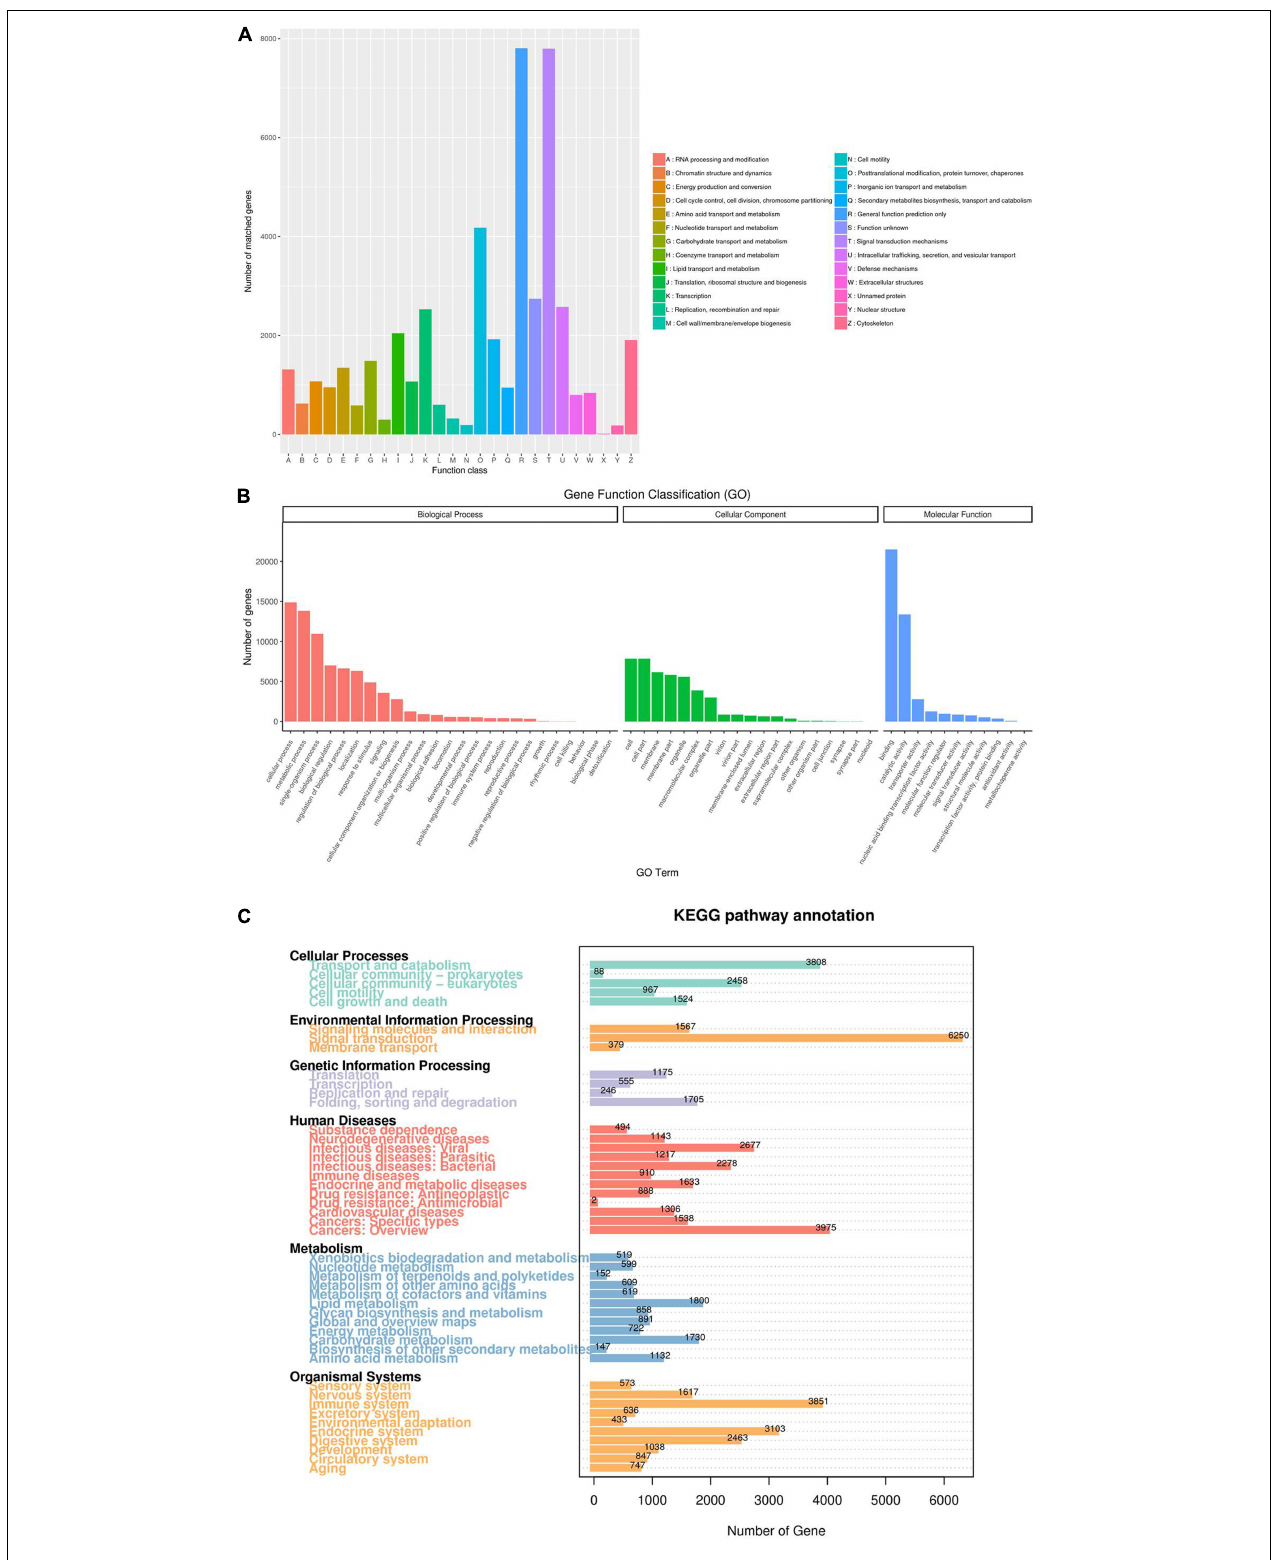
FIGURE 5 | Functional classification of the long-read transcripts. (A) Clusters of Orthologous Eukaryotic Genes (KOG) classification. (B) Gene Ontology (GO) classification. (C) Kyoto Encyclopedia of Genes and Genomes (KEGG) pathway classification.